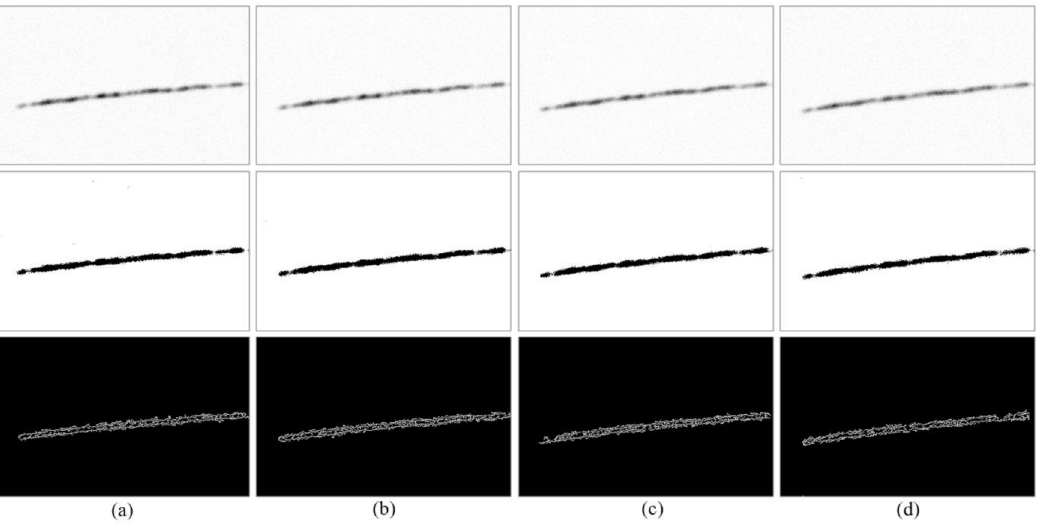
Figure 14. Comparative results—top: gray image for the original image, middle: CAE, bottom: Canny edge detection: ( a ) 344th; ( b ) 345th; ( c ) 346th; ( d )